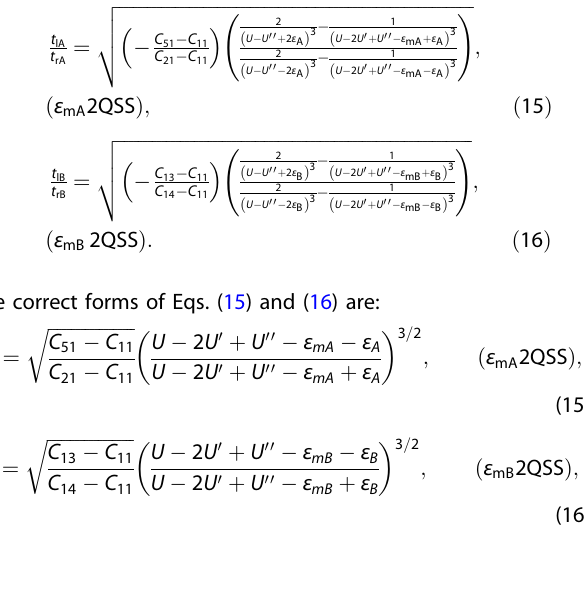
ffiffiffiffiffiffiffiffiffiffiffiffiffiffiffiffiffiffiffi C (cid:2) C 13